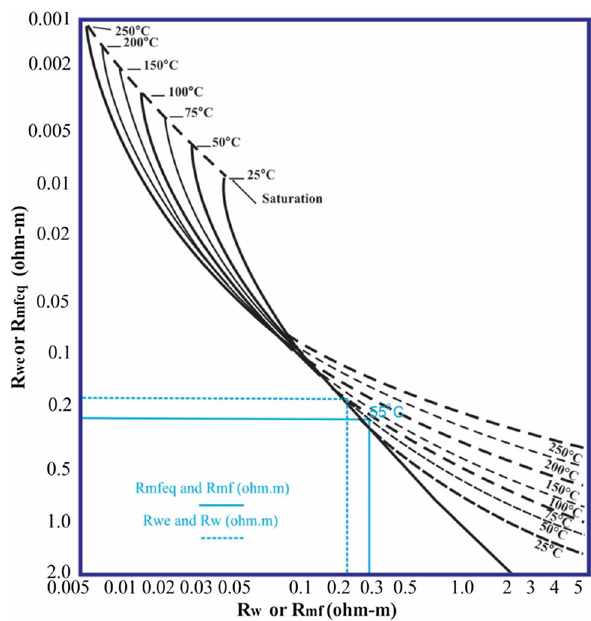
Fig. 5 Schlumberger chart showing Rmf, Rmfeq and Rwe and R ues at formation temperature for Lockhart Limestone of Meyal-05P (modified after Schlumberger 2009) Table 1 Carbonates porosity types V